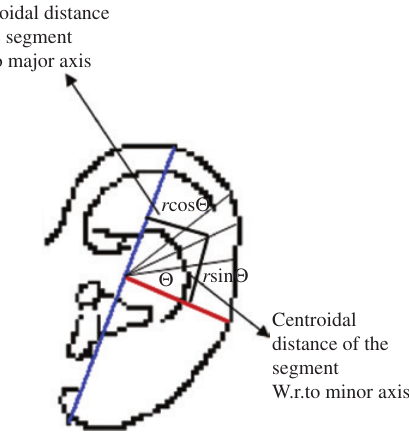
Figure 6: Centroid Location of the Circular Sector